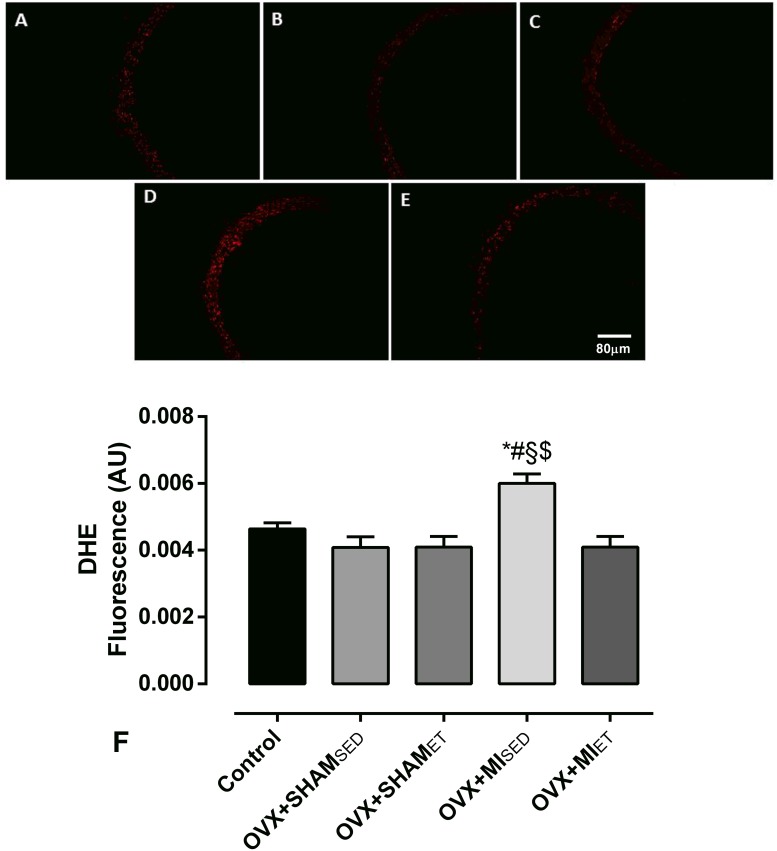
Evaluation of superoxide production "in situ" by micrographs depicting the fluorescence emitted by dihydroethidium in segments of the aorta vessels.Data are expressed as mean ± standard error of the mean (SEM). One-way ANOVA followed by the Fisher post-hoc test for multiple comparisons. *p <0.05 vs Control; #p <0.05 vs OVX+SHAMSED; §p <0.05 vs OVX+SHAMET; $p <0.05 vs OVX+MIET.